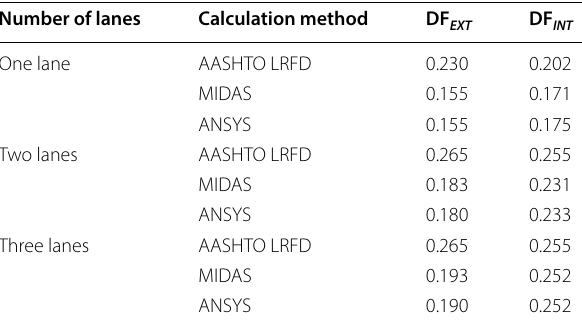
Table 3 Distribution factors for different number of